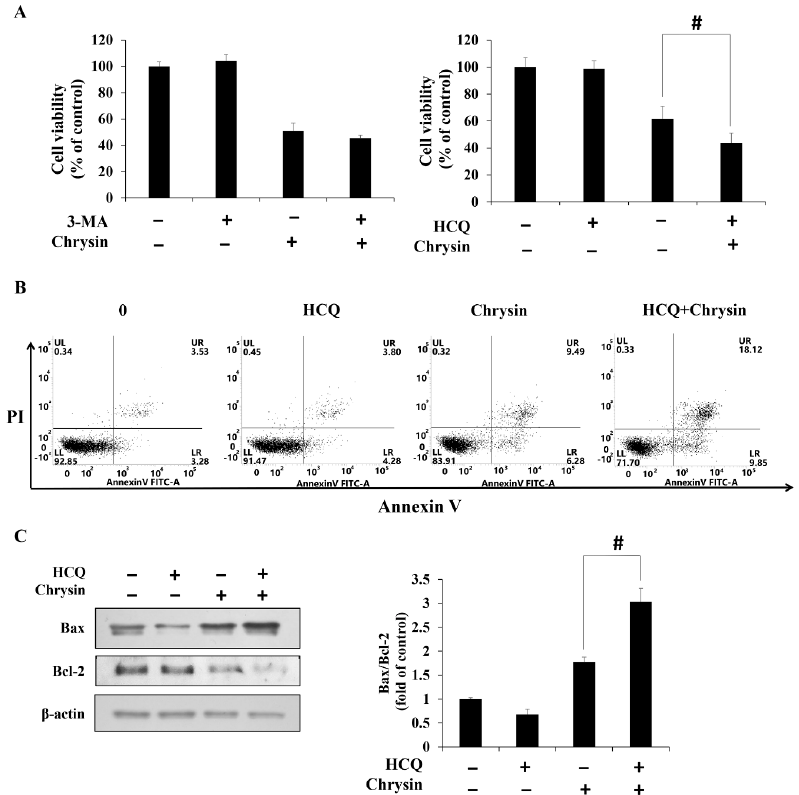
Figure 4. Chrysin induces cell protective autophagy in MC-3 oral cancer cells. ( A ) Viability of cells pre-treated with 3-methyladenine and hydroxychloroquine (HCQ) and subsequently treated with chrysin. ( B ) Apoptosis rates of cells pre-treated with HCQ and subsequently treated with chrysin. ( C ) The level of apoptosis-related proteins Bax and Bcl-2. Quantification was performed using Image J. The results are presented as the means and standard deviation of three independent samples. The statistical differences were determined by the Dunnett’s t -test: # p < 0.05, compared with the chrysin treatment group.